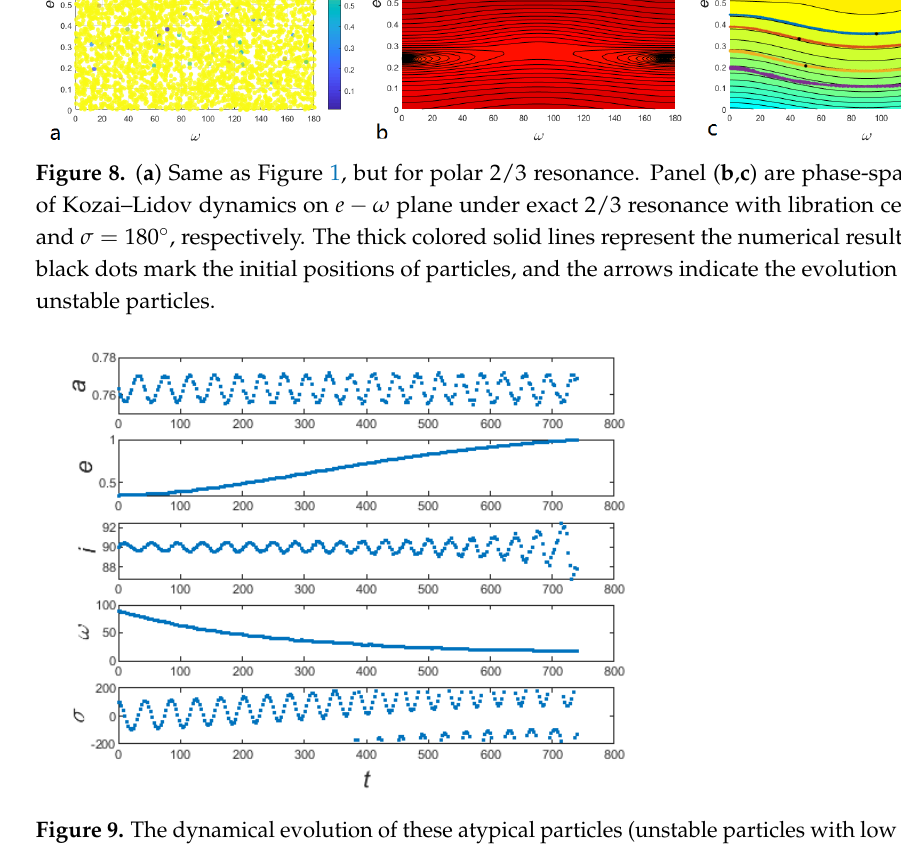
Figure 9. The dynamical evolution of these atypical particles (unstable particles with low eccentricity) in Figure